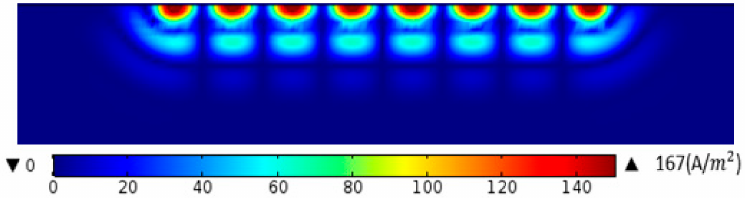
Figure 13. Eddy current distribution in aluminum plate after adding ANSM.